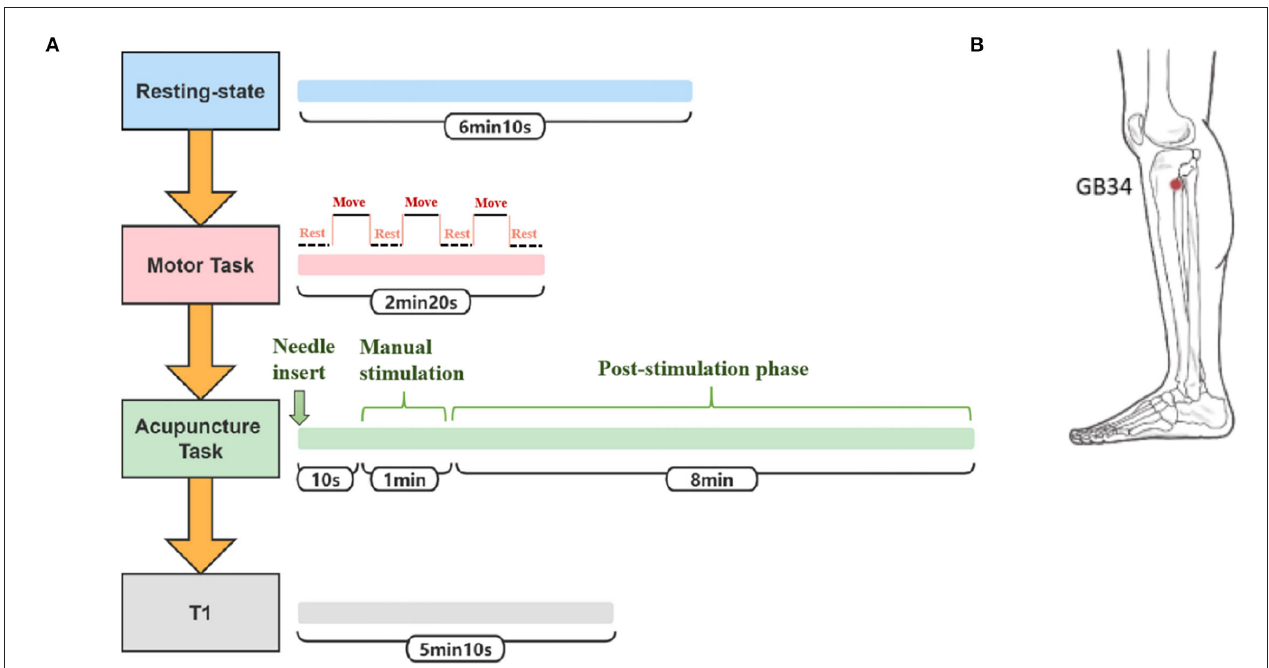
FIGURE 2 | Study design. (A) The scanning protocol. (B) The location of Yanglingquan